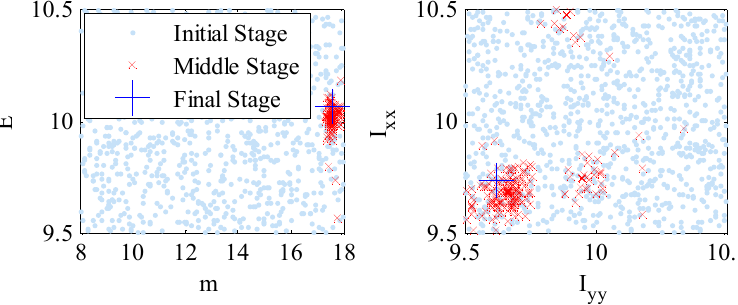
Figure 8. Plot of samples in the structural model parameter space generated at the initial, middle and final stages of TMCMC for model class M 1 .